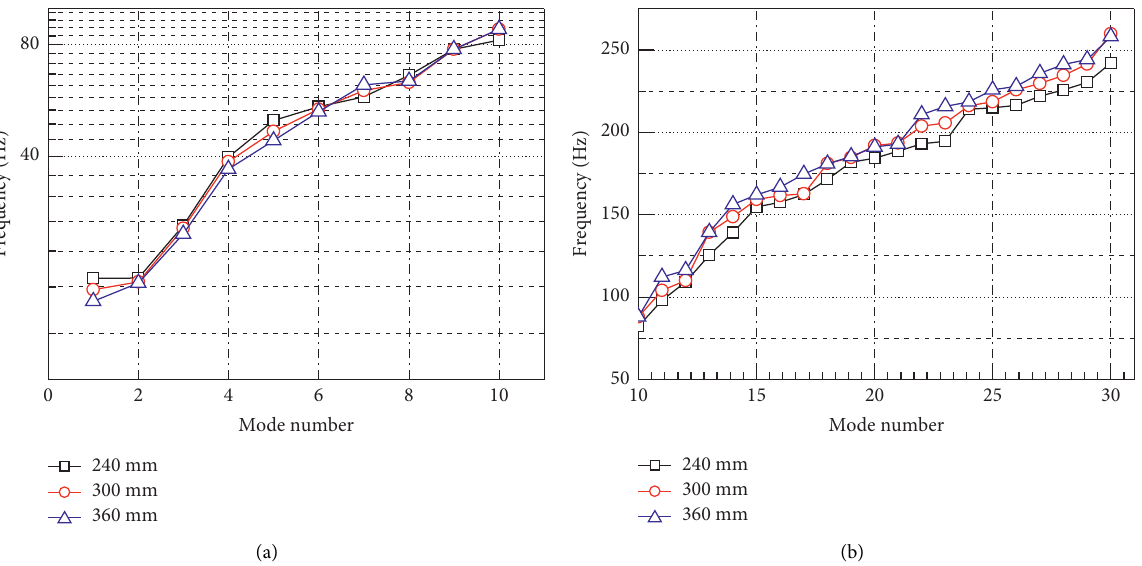
Figure 10: The first thirty natural frequencies for different values of the plate thickness. (a) The first ten natural frequencies. (b) Natural frequencies of various modes (10–30).